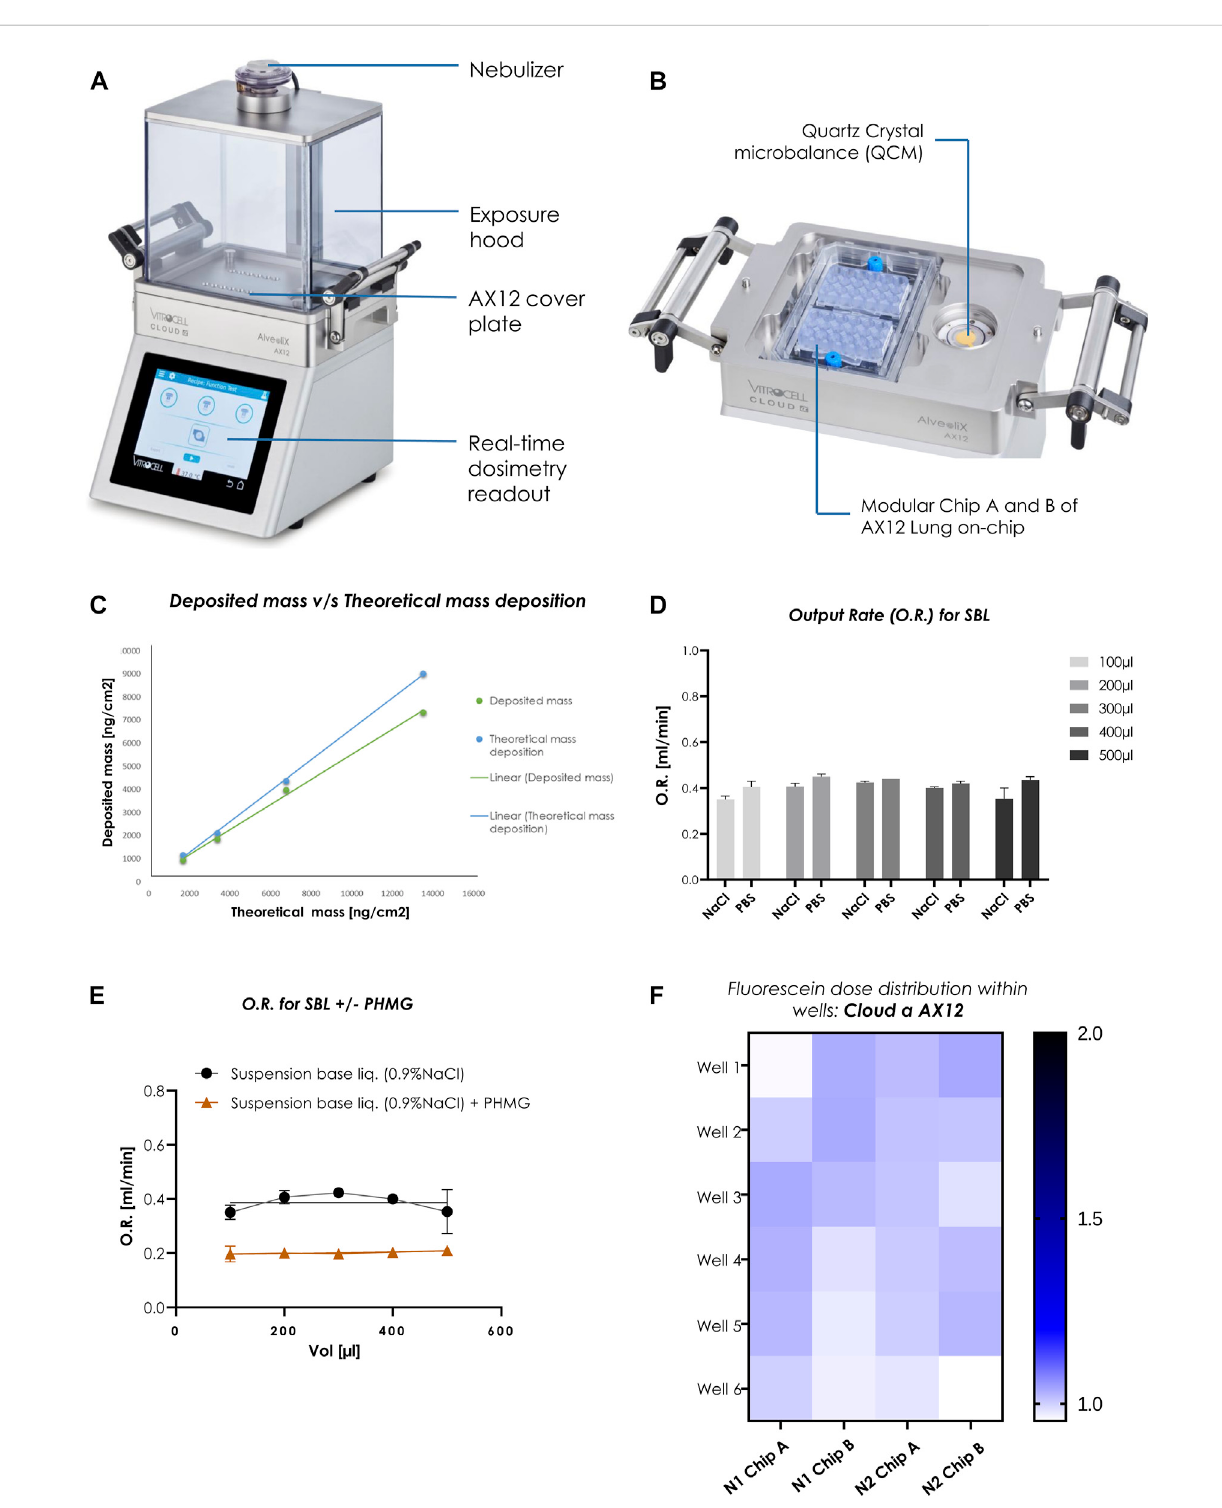
FIGURE 2 Homogenous dose distribution using the Cloud α AX12 (A) Design of the Cloud α AX12 comprised of a stainless-steel base module maintained at 37 ° CcontainingtheAX12plateplacedontopcoveredbyasteelplate.Theholesonthesteelbase-platearealignedtothewellswithintheAX12plate.The QCM6placedinsidethepolycarbonateremovableexposurehoodquantifyreal-timecelldelivereddoseandarerecordedandanalyzedwiththeVitrocell software. The nebulizer ontop relies ona piezoelectric vibrating meshto form aconsistent aerosol cloud from thesolubilized substance nebulized. (B) Detailed closer inspection of the orientation and placement for the AX12 plate and the QCM 6 sensor. (C) Comparison between deposited mass as measured from theQCM6 readings (in green) and theoretically calculated (in blue). (D) O.R. (mL/min) was measured for differentvolumes (100 – 500 µL) for two SBLs (0.9% NaCl in distilled water and 1% PBS in distilled water) (n = 3). Data shown as mean ± SEM. (E) PHMG compound was dissolved in NaCl suspensionbaseliquidasareference.O.R.wasmeasuredforSBLwithoutandwithcompounddilutionusingtheCloud α AX12(n=3). (F) Dosedistribution measured from fl uorescence signals [A.U.] of nebulized Fluorescein deposited on-chip. Signals from each well depicted in color scheme (white to blue; low fl uorescence signal to high) from two individual rounds in AX12 plates (N = 2; n =